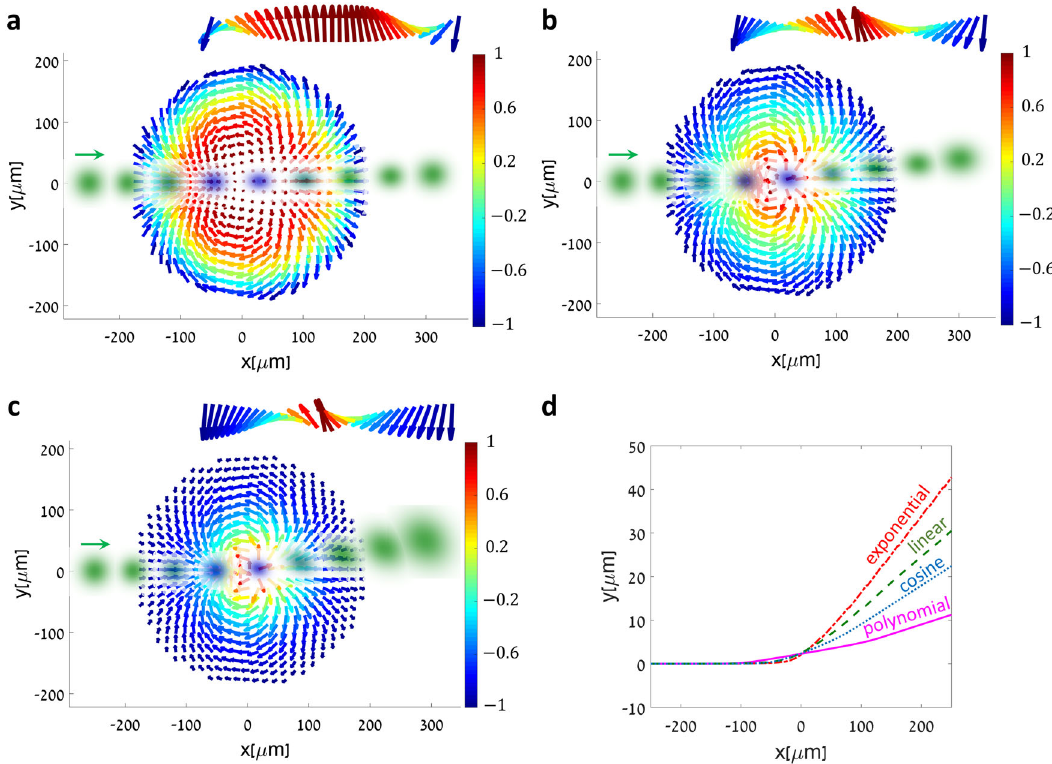
Fig. 4 Tailoring domain walls to engineer the topological Hall effect for light. Simulated beam shape and position in the transverse plane of the crystal, for selected depths of propagation inside the NLPC and different domain wall distributions ( R ¼ 200 μ m ; n ¼ 2 ; η ¼ 0, and beam angle 1 : 5 (cid:3) in all panels; (cid:4) (cid:5) (cid:4) (cid:5) (cid:4) (cid:5) 3 (with B / ρ ). b linear dependence m ρ ¼ 1 (cid:2) 2 ρ = R ¼ 1 (cid:2) 2 ρ = R insets show the domain wall cross sections). a cubic polynomial dependence m ρ (cid:4) (cid:5) ¼ exp ð(cid:2) ρ = R Þ½ 1 (cid:2) ð ρ = R Þð 1 þ e Þ(cid:4) (with B / exp ð(cid:2) ρ = R Þ = ρ ). Inset is the transverse component of the synthetic (with B / 1 = ρ ). c exponential dependence m ρ magnetization in the NLPC, color-coded by its corresponding z -component. It appears that the de fl ection becomes more dominant as the domain wall transition effectively occurs in a smaller area. d Simulated center-of-mass trajectories of the light beams traversing the different domain walls of a – c , as (cid:4) (cid:5) ¼ cos ð πρ = R Þ , with B / sinc πρ = R compared to a conventional Néel-type skyrmion ( m ρ